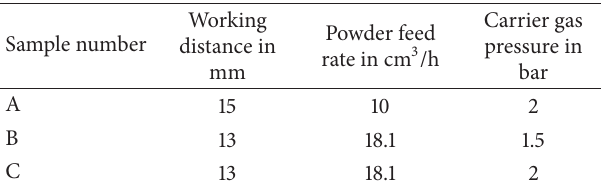
Table 2: Parameter sets for atmospheric pressure plasma deposition of different PMMA/ATH